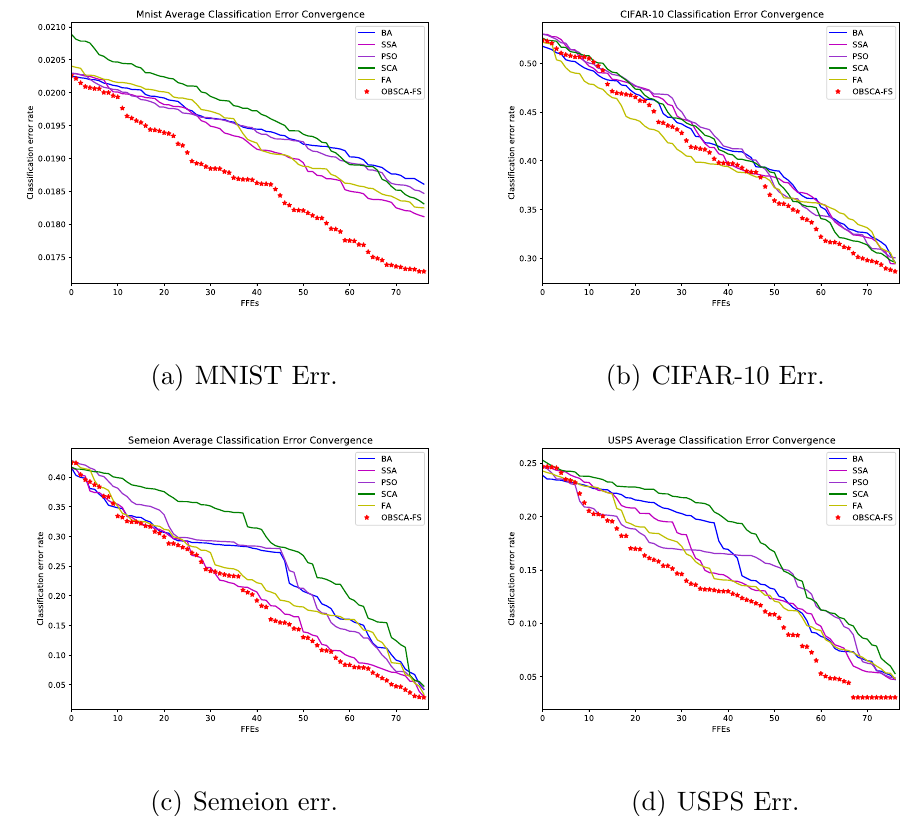
Figure 5. Convergence graph of MNIST, CIFAR-10, Semeion and USPS datasets for average classification error for OBSCA-FS, SCA and WOA.